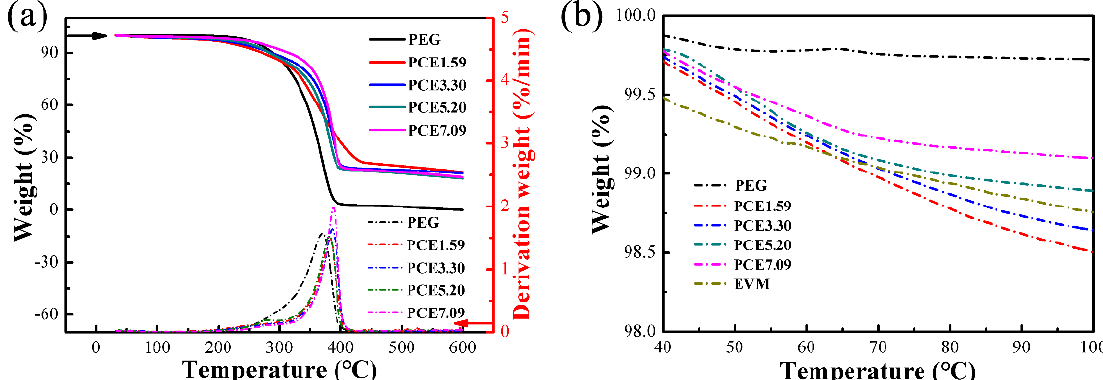
Figure 9. ( a ) Thermogravimetric analysis-derivative thermogravimetry (TGA-DTG) curves of PEG and PCE-CPCMs from 35 to 600 °C, and ( b ) the enlarged TGA curves from 40 to 100 °C.